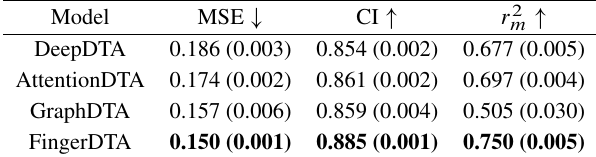
Table 3 Comparison with state-of-the-art models on the KIBA data set.